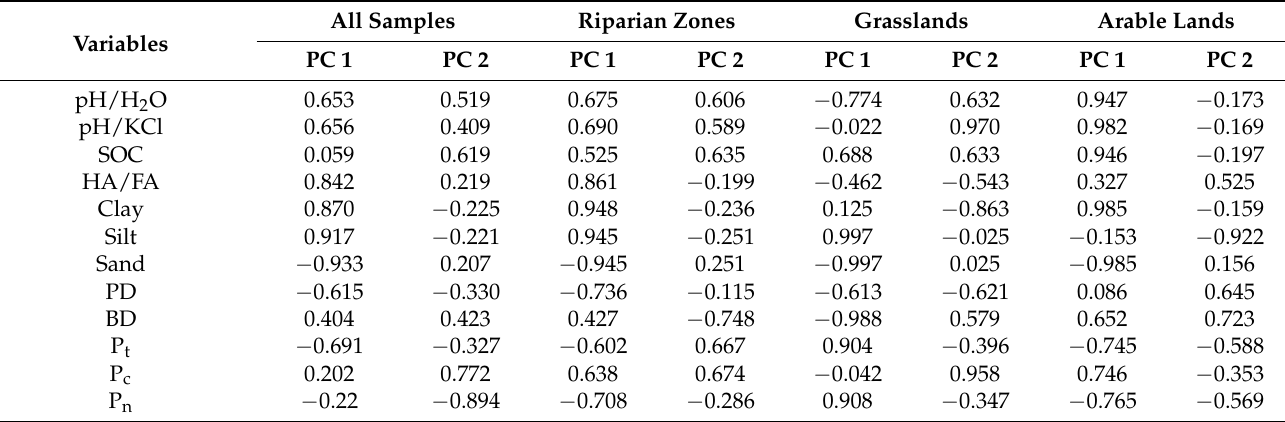
Figure 3. Results of PCA relationships between hydrological and soil properties. Table 5. Component matrix for variables.